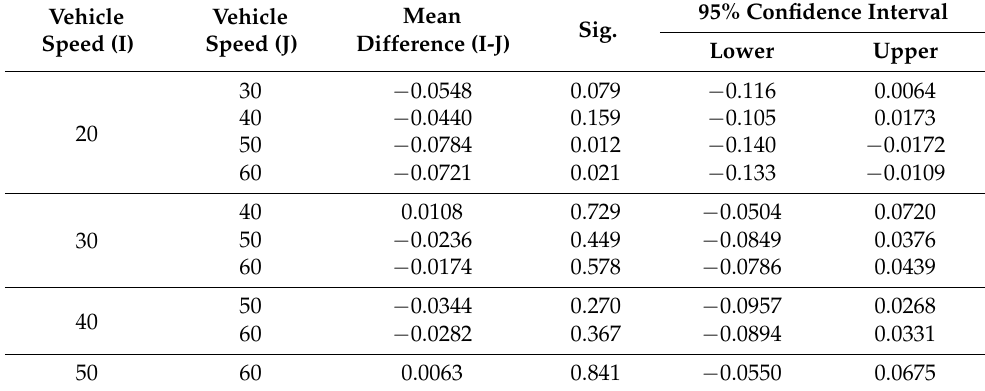
Table 6. Multiple comparisons of the effect of vehicle speeds on pedestrian crossing speed.